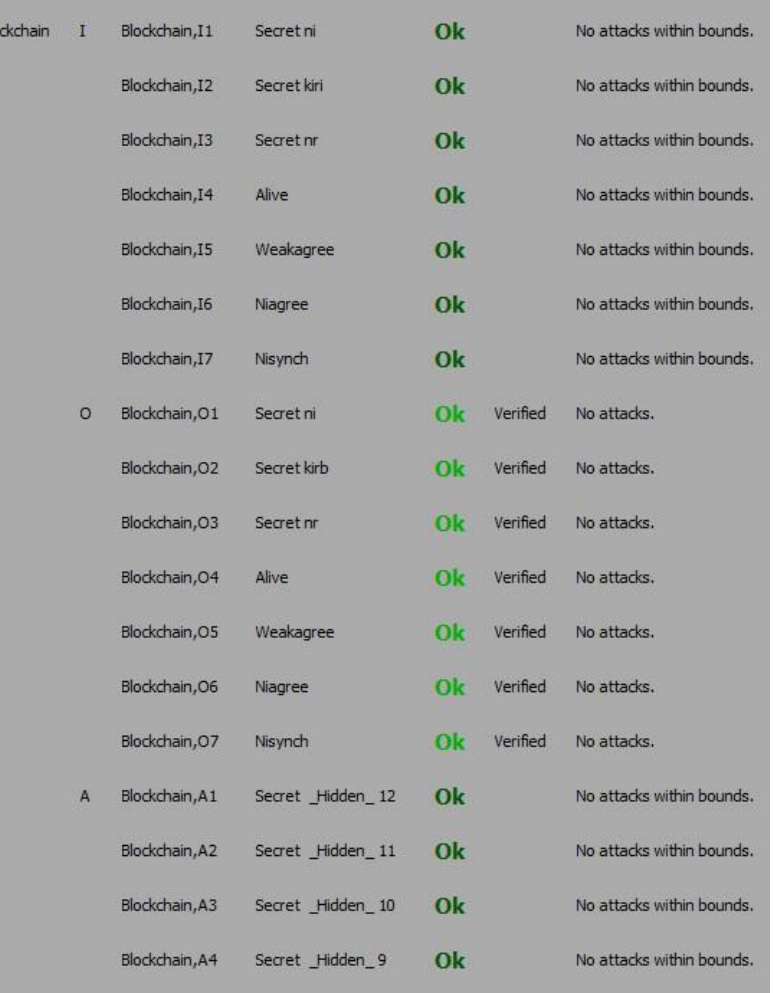
Figure 3. The verification result of the automatic claim.